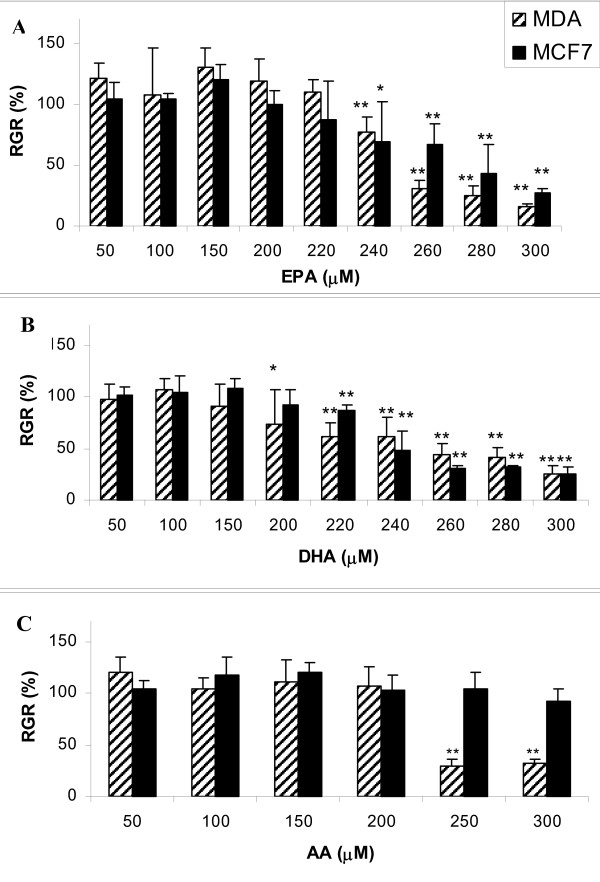
Effects of PUFA on viability of breast cancer cells. The effect on cell viability of PUFA in MDA-MB-231 and MCF7 cells is assessed and quantified by MTT assay. Cells are treated with various concentrations of EPA (A), DHA (B), and AA (C). Cells are seeded and cultured for 48 h in a 96-well plate, after this period, the medium is replaced with fresh medium for treatments with AA, EPA, or DHA and incubated for further 72 h. The numbers of viable cell exposed to fatty acids are evaluated by a colorimetric 3-(4,5-dimethylthiazol-2-yl)-2,5-diphenyltetrazolium bromide (MTT) assay. Data represent the mean of eight values and results are expressed as Relative Growth Rate (RGR) in comparison with controls (100%). * p < 0.05; ** p < 0.01 compared to control cells.